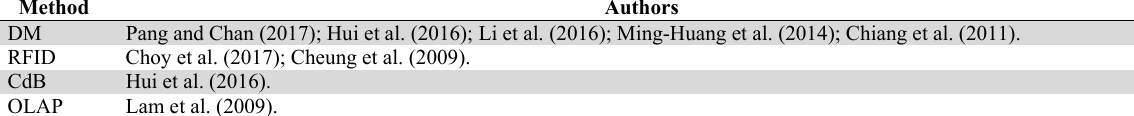
Relationship between other solution trends and authors. Source: the authors Method